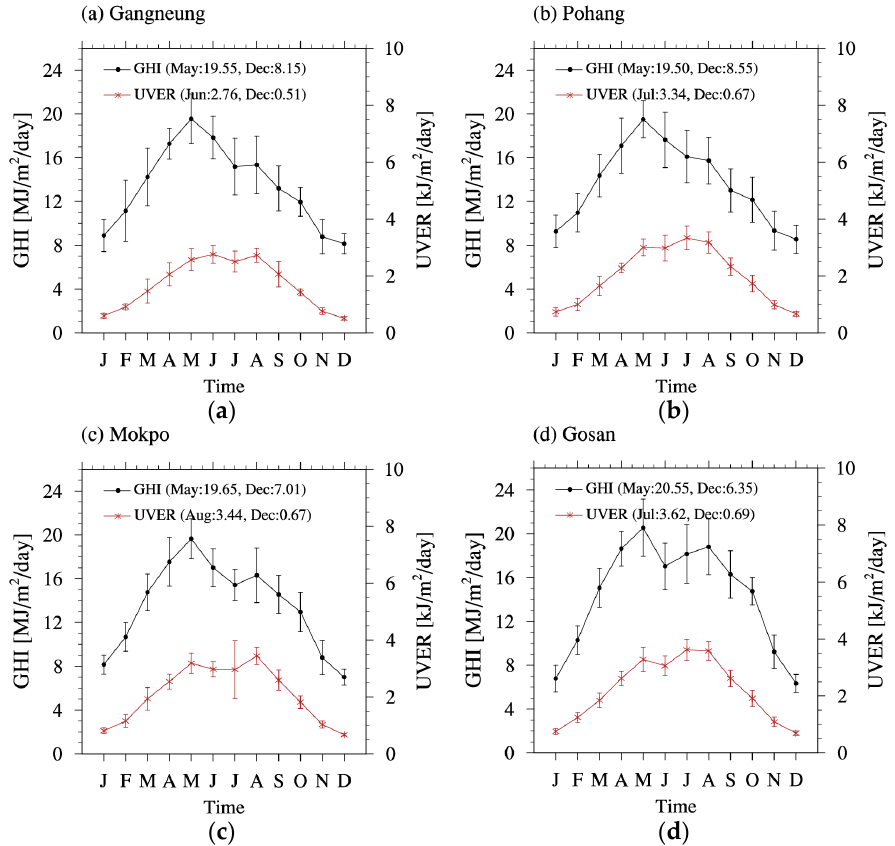
Figure 2. Monthly mean values of daily accumulated global solar radiation (black filled circle) and erythemal UV radiation (red asterisk) at ( a ) Gangneung, ( b ) Pohang, ( c ) Mokpo, and ( d ) Gosan.